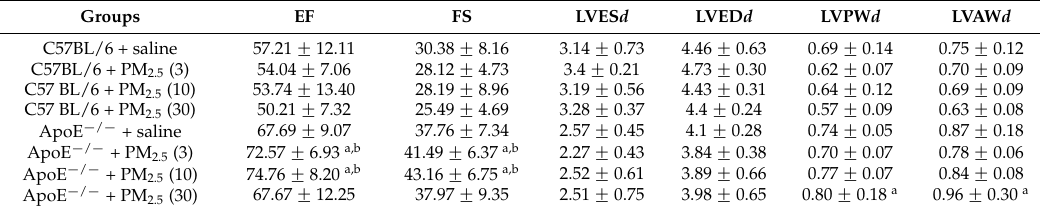
Table 4. Echocardiography changes in experimental groups after PM 2.5